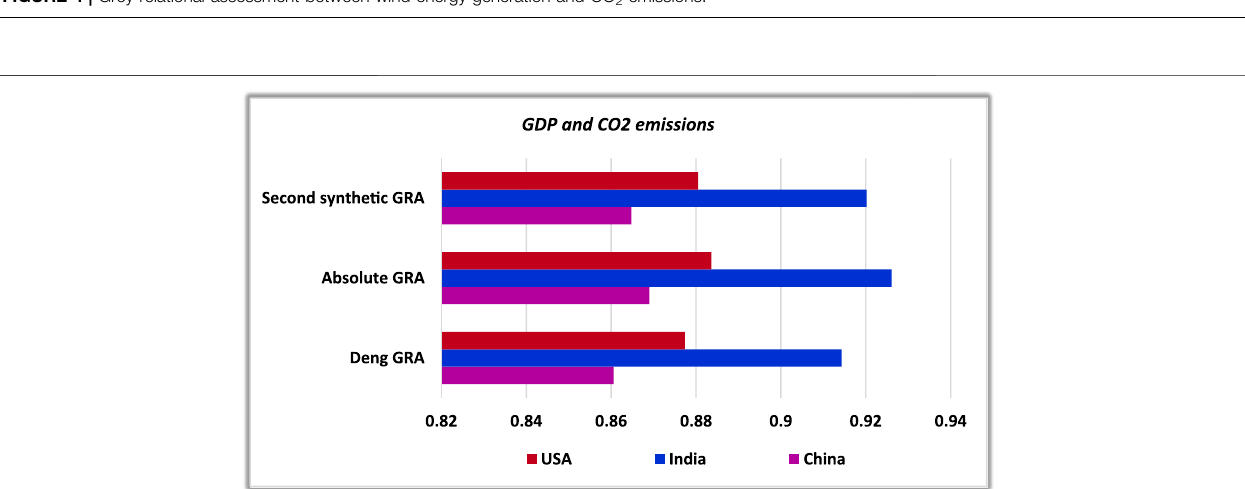
FIGURE 5 | Grey relational assessments between GDP per capita and CO 2